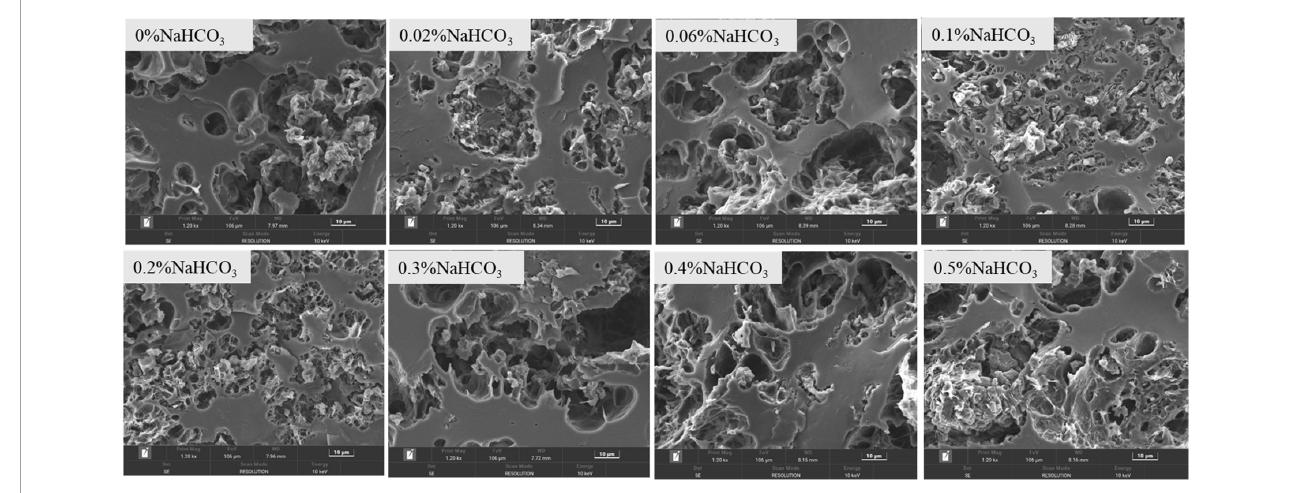
FIGURE6 Effect of sodium bicarbonate on the microscopic morphology of semi-dried rice noodles.